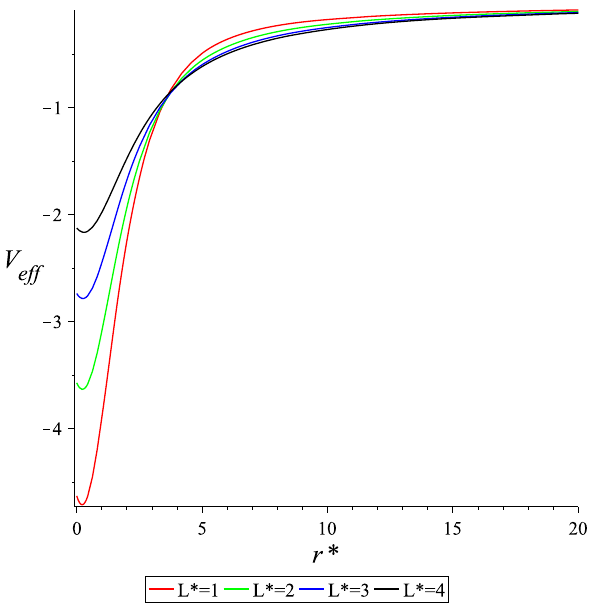
Fig. 3 Effective potentials for timelike particle with E = 1, L ∗ = 2, l ∗ = 2, and the rotational parameter a ∗ = 0 . 5. The electric field b ∗ varies from 0 to 0 . 6